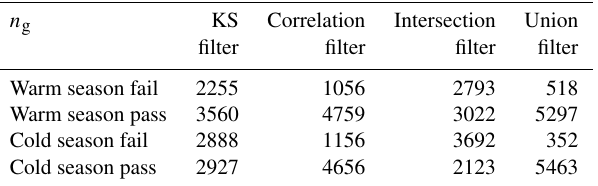
Figure 6. (a) Warm season grids that pass the correlation filter and/or the KS filter. Dark green grids include grids that pass inter- section filters. (b) Cold season grids that pass the correlation filter and/or the KS filter. Dark orange grids include grids that pass inter- section filters. In both figures, white grids show the grids that pass neither filter and will be cross-hatched in index maps. Table 1. Number of grids, out of total 5815, that fail and pass the quality control for each filter.